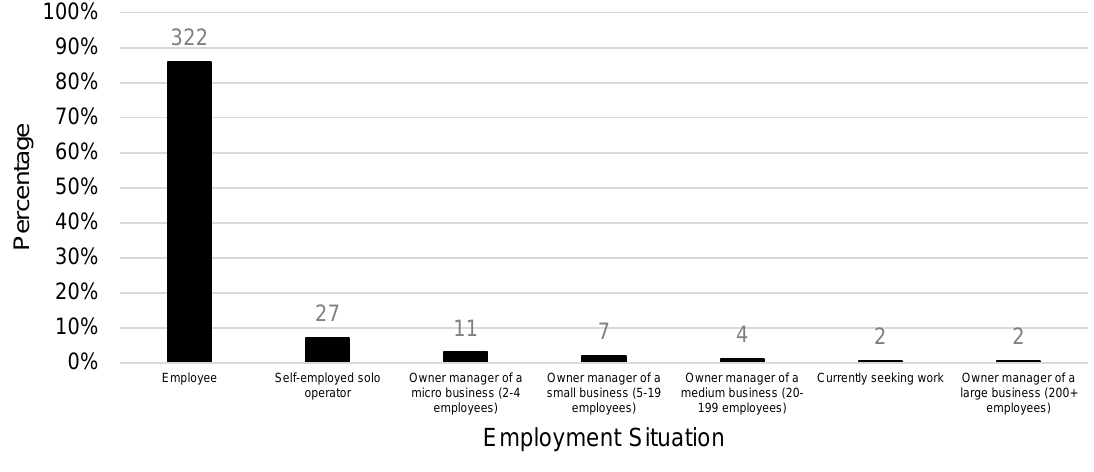
Figure 3. Employment situation of participatory and deliberative practitioners (n=375).